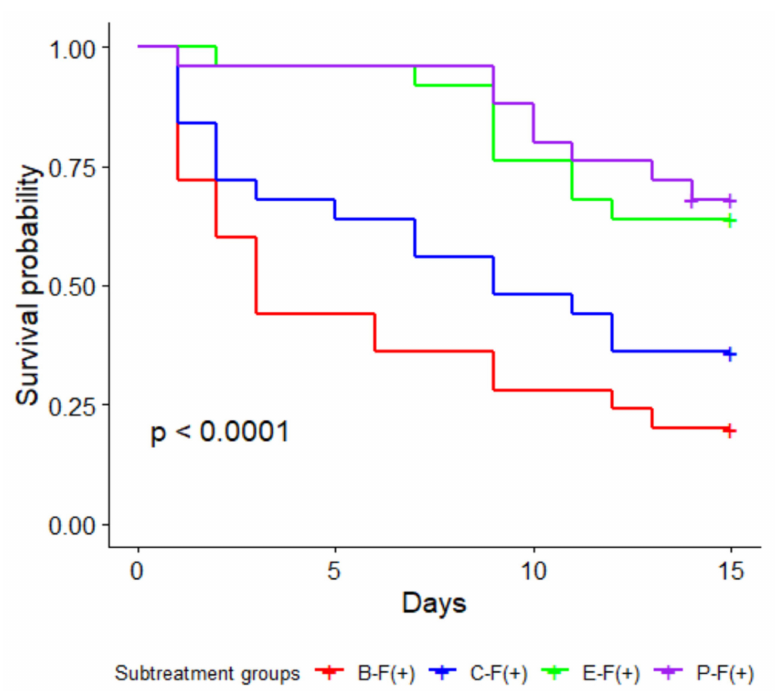
Figure 2. Kaplan–Meier curve showing the proportion of alive Tenebrio molitor larvae recorded over two weeks in four probiotic treatment groups. Blue: control (C); red: Bacillus subtilis (B); green: Enterococcus faecium (E); and violet: Pediococcus pentosacceus (P). Larvae were exposed to the fungus Metarhizium brunneum strain KVL 12–37 and observed for 14 days as a part of the fungal pathogen challenge experiment. Highest mortality was observed for fungus-treated larvae fed with B. subtilis bacterium, which was significantly different from the two probiotic treatment groups but not from the control group. The least mortality was observed for larvae supplemented with P. pentosacceus strains, which was significantly different from B. subtilis treatment groups but not from E. faecium and control groups. Different letters at the right end of the curves indicate significant differences ( p < 0.05, Bonferroni adjustment for multiple comparisons) between the corresponding treatment